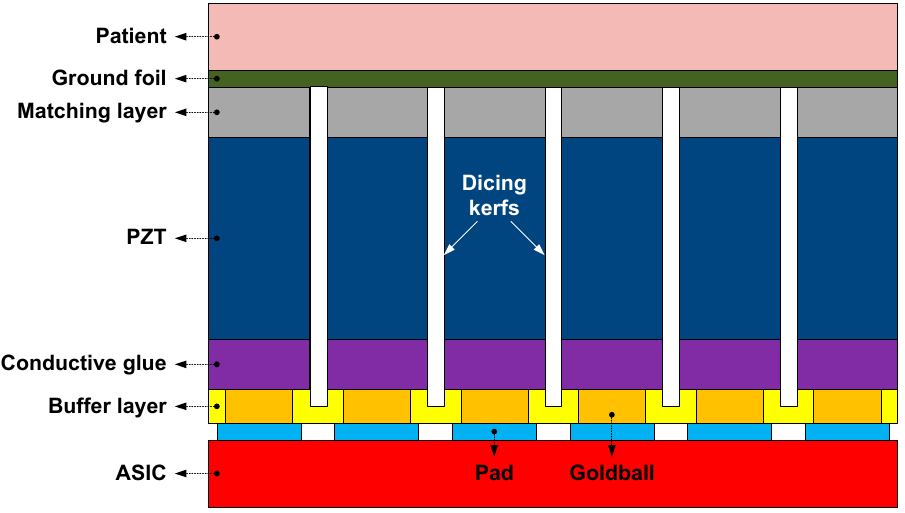
Figure 2. Cross-sectional view of the transducer array mounted on top of the ASIC.